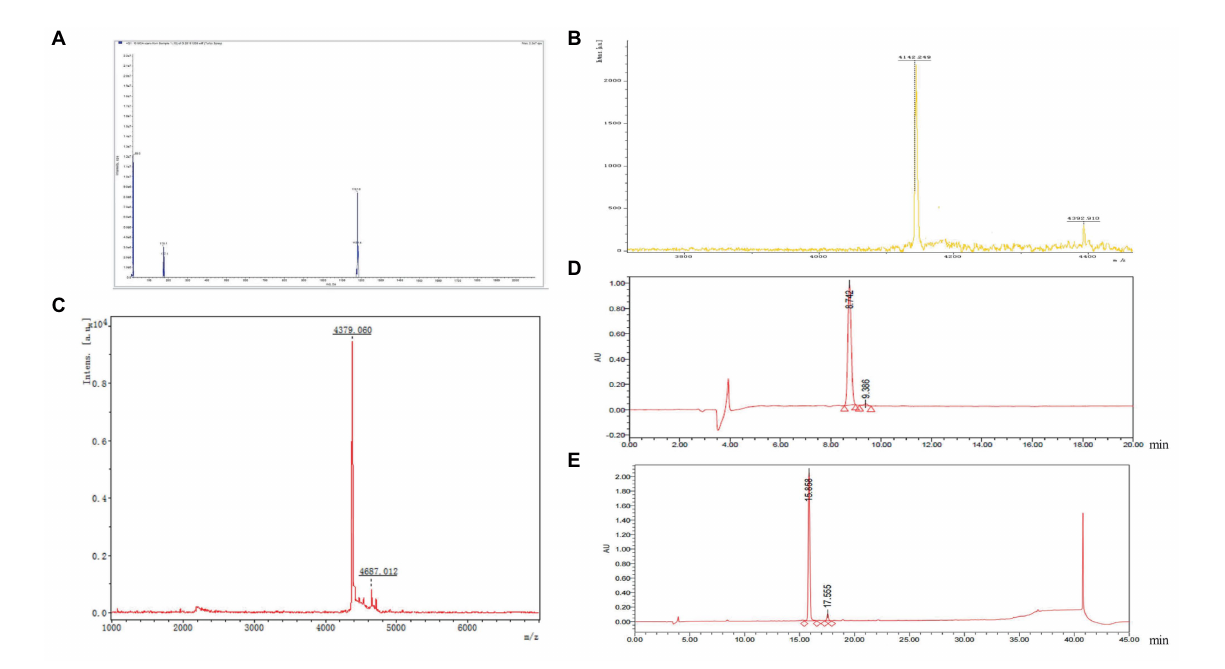
FIGURE 2 (A) The results of mass spectrometry analysis of the molecular weight of GnRH. (B) The molecular weight of the G1 polypeptide antigen was determined by mass spectrometry and verified to be 4142.249. (C) The molecular weight of G2 peptide antigen was determined by mass